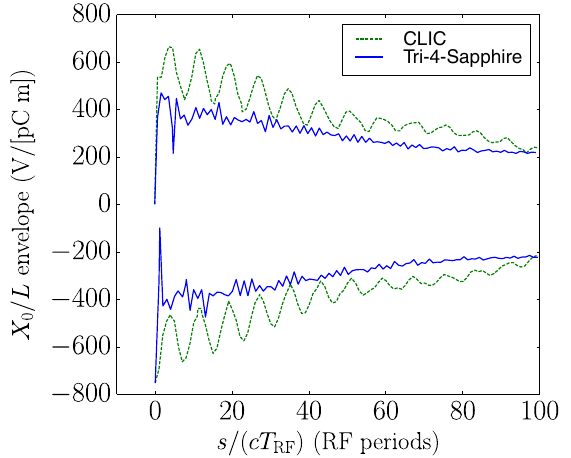
FIG. 7. Transverse dipole wake potentials in the Tri-4- Sapphire cavity are (on average) an order of magnitude higher than those in CLIC.